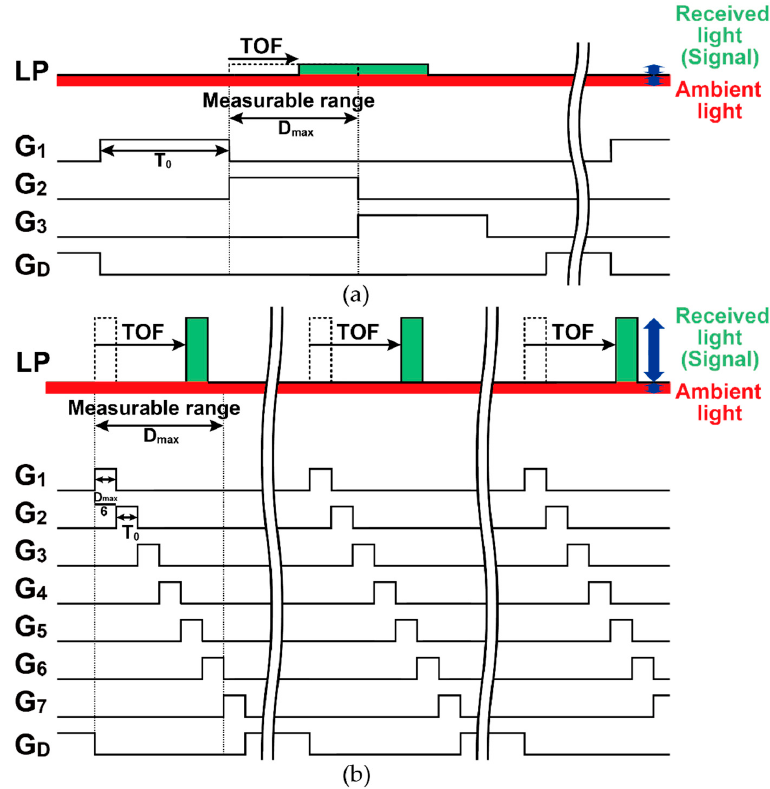
Figure 2. Short-pulse time-of-flight (SP-TOF) measurement using a multiple-tap lock-in pixel imager: ( a ) 3-tap with one window and ( b ) 7-tap with six windows.